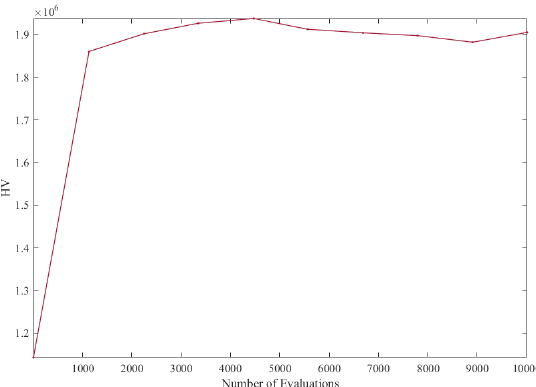
Figure 8. HV curve of the PUSS model.